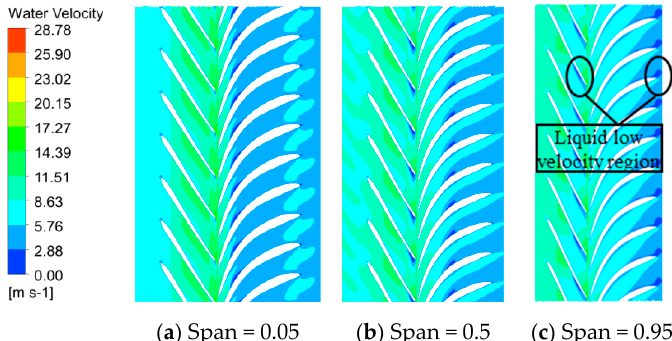
Figure 11. Water velocity distribution at diverse spans in the second impeller and diffuser under IGVF = 20%.